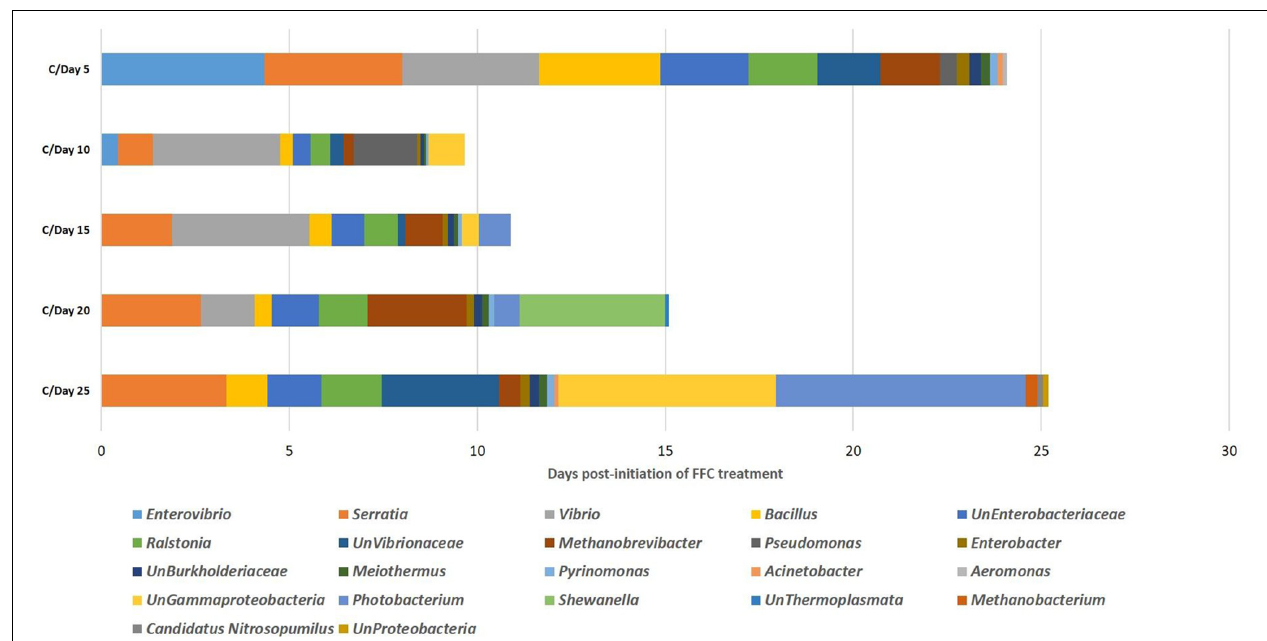
FIGURE 7 | Similarity percentages analysis showing the microbial taxon contributing to the discrimination between different days of FFC